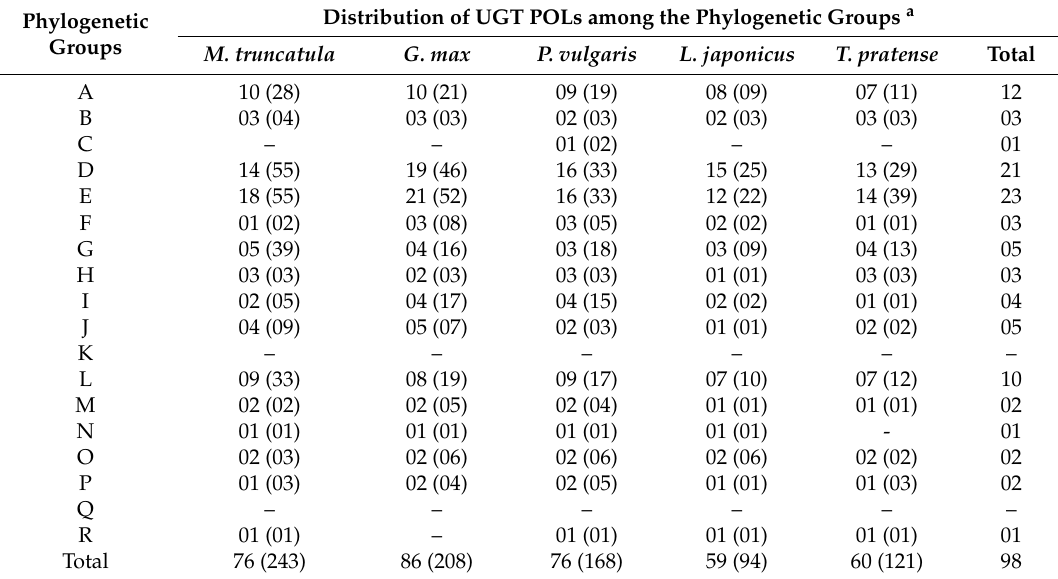
Table 2. Distribution of UGT POLs among the